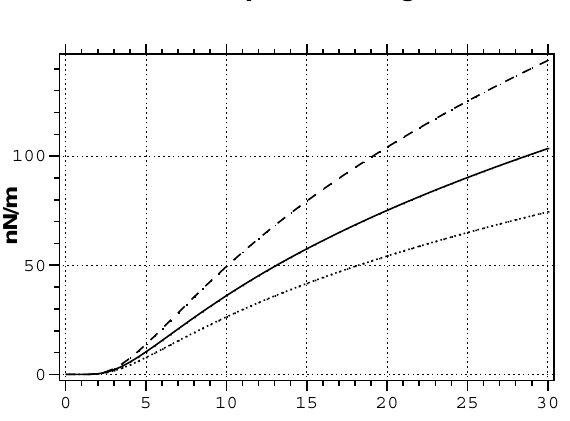
Fig. 1. Force per unit length according to Eq. (8) as function of voltage V 0 . Solid curve is for baseline electron temperature 12eV, dotted for 6eV and dashed for 24eV. Solar wind electron density n 0 = 7 . 3cm − 3 , velocity v = 400km/s and wire radius r w = 10 µ